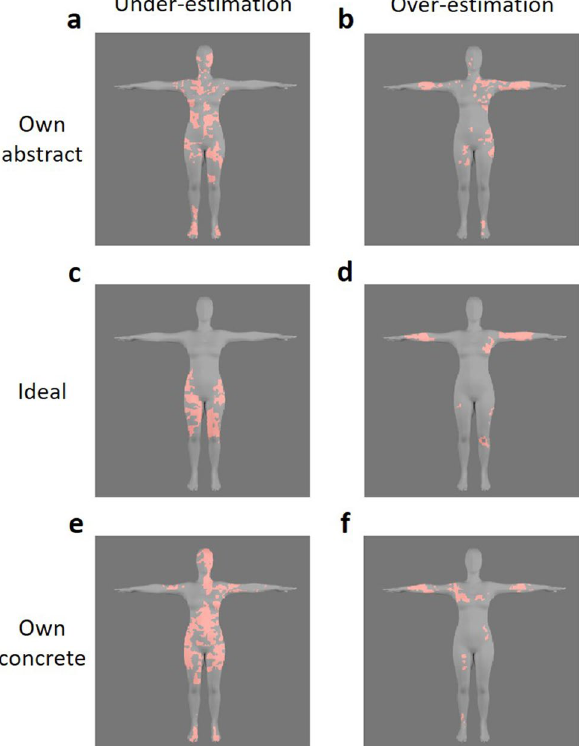
Figure 5. Diagnostic areas for under- versus over-estimators. Areas that significantly correlated with participants’ responses were calculated for under- (perceived hip width smaller than real hip width) and over- estimators (perceived hip width bigger than real hip width) separately. In the left-side column, areas that were significantly more predictive for under-estimators are displayed. These areas were calculated by subtracting the diagnostic areas observed in the overestimation group from those observed in the underestimation group. The reverse was done to calculate the areas that were significantly more predictive for over-estimators (right-side column). The diagnostic areas were calculated for all conditions separately: (a,b) for own abstract ( Which of these two bodies looks most like your own? ), (c,d) for ideal ( Which of these two bodies looks most like the body you would like to have? ), and (e,f) for own concrete ( Which of these two bodies looks most like the body you would use for online shopping? ) body